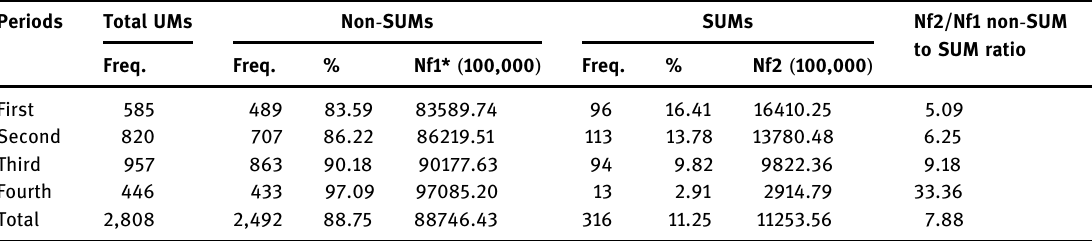
Table 3: SUMs and non - SUMs along the four time periods